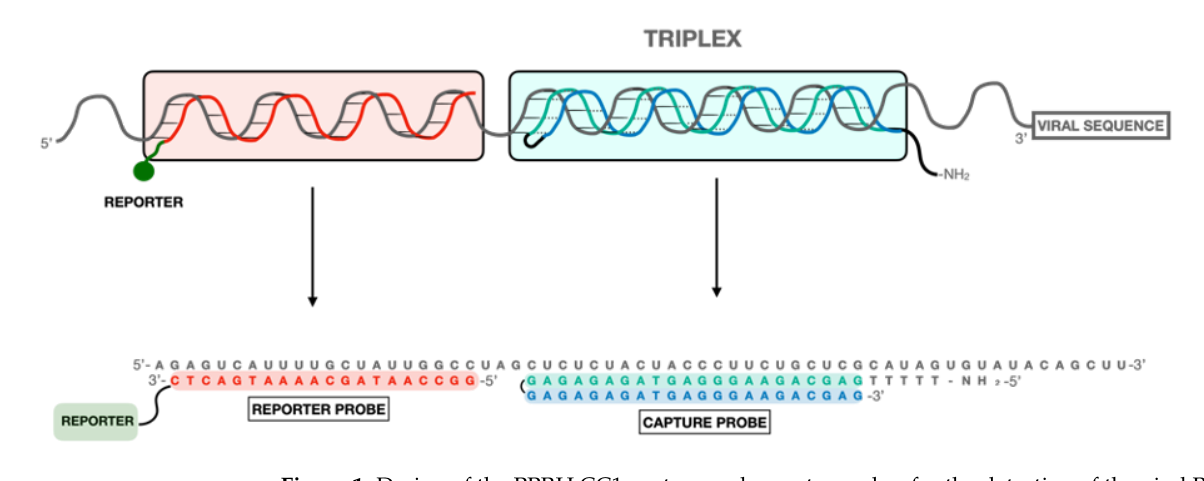
Figure 1. Design of the PPRH CC1 capture and reporter probes for the detection of the viral RNA.